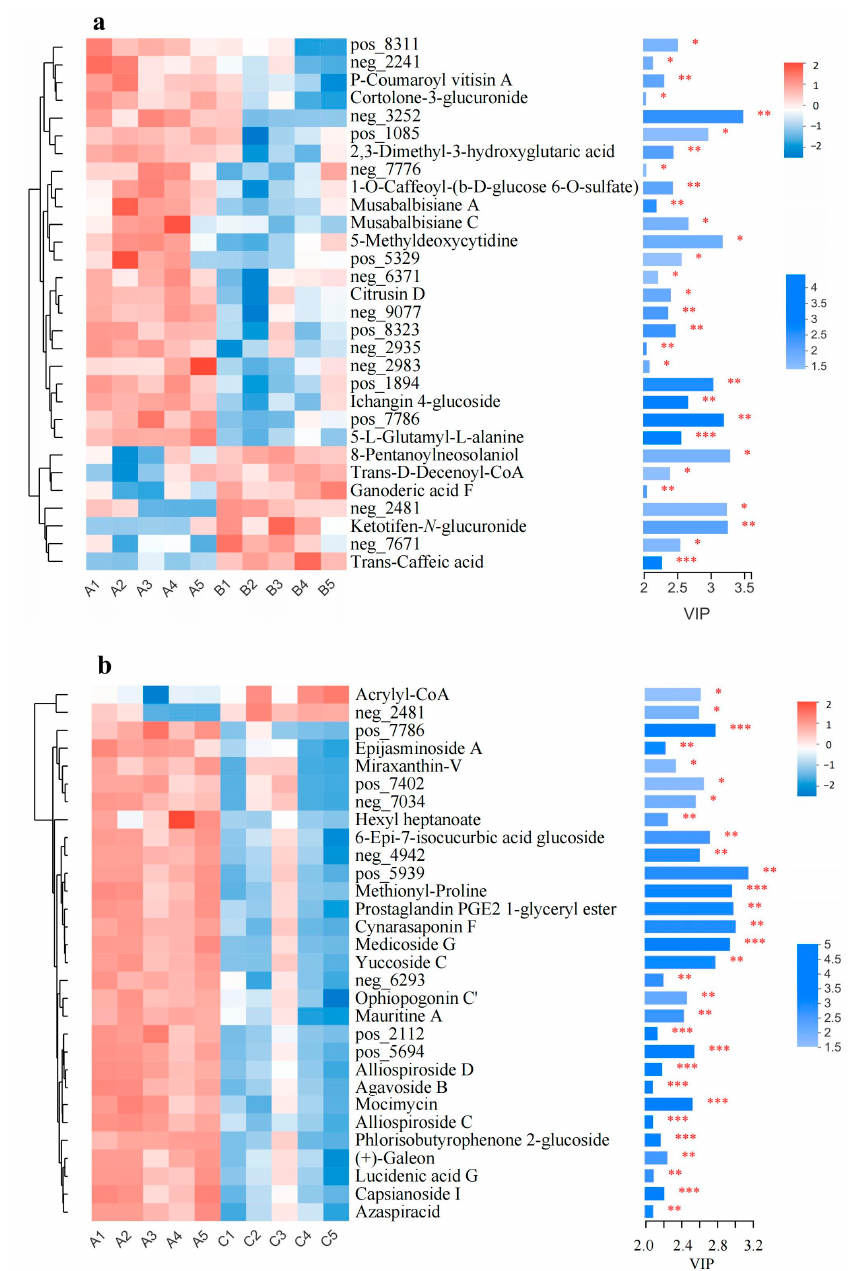
Figure 6. The top 30 SCMS with VIP value > 1 and p < 0.05 in CW seedlings under cold stress, ( a ) B vs. A ( b ) C vs. A. Clustering heat map is on the left, each column represents a sample, and the sample name is below. Each line represents a SCM, and the color represents the relative abundance of the metabolite in the samples. Red and blue colors mean higher and lower abundance, respectively. The VIP bar chart of the SCMs is on the right, the bar length indicates the contribution value of the metabolite to the difference between the two treatments, the greater the value, the greater the difference between the two treatments. The bar color indicates the significant difference ( p -Value) of metabolites between the two treatments, the smaller the value, the larger the − log10 ( p -Value) and the darker the color. Asterisk (*) indicates p < 0.05, asterisk (**) indicates p < 0.01, asterisk (***) indicates p < 0.001. A, C. weiningensis treated with 20 °C; B, C. weiningensis treated with 4 °C; C, C. weiningensis treated with − 4 °C.